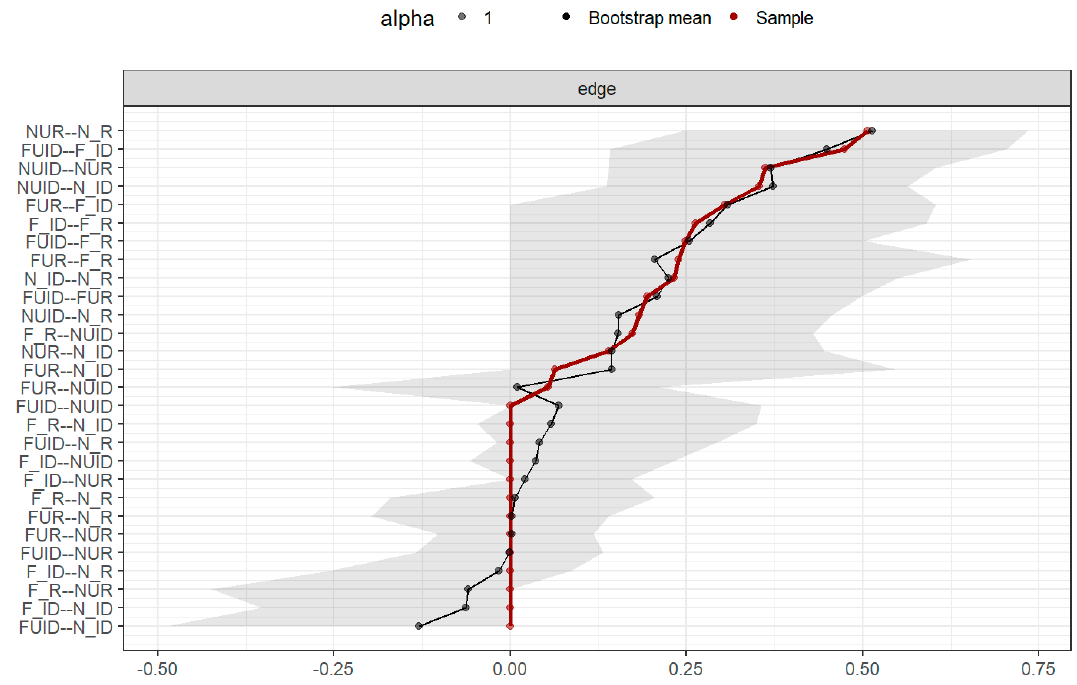
Figure 10. Centrality stability is investigated using subset bootstrapping for the North American subsample.